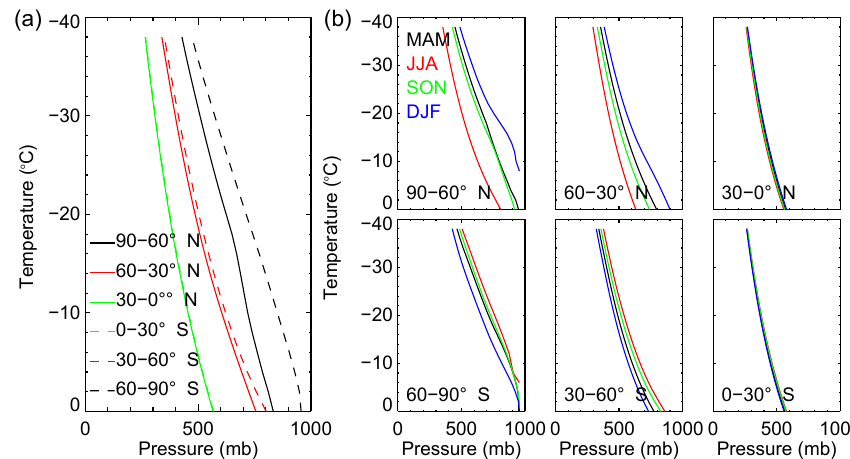
Figure 4. Atmospheric pressure profiles with subfreezing temperatures for (a) the six latitude bands and (b) their seasonal variations. MAM stands for March–April–May, JJA for June–July–August, SON for September–October–November and DJF for December–January– February.